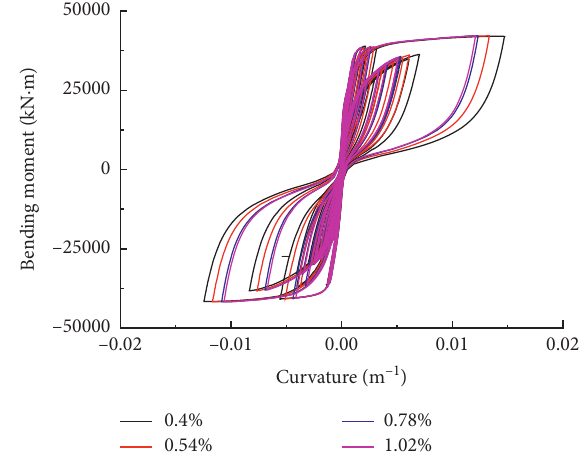
Figure 5: Comparison of hysteretic curves with different stirrup ratios.